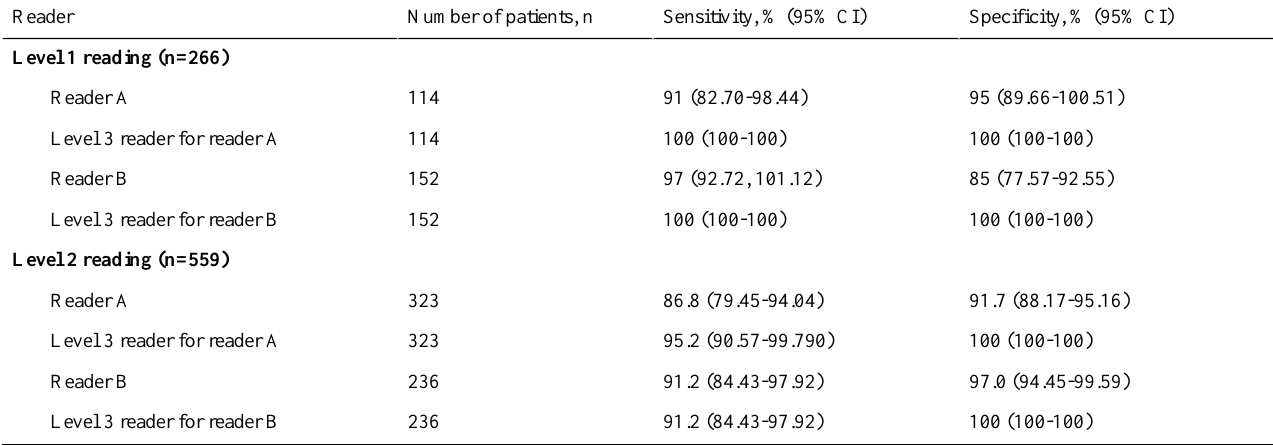
Table 3. Sensitivity and specificity for the identification of patient referrals by each reader versus the consensus gold